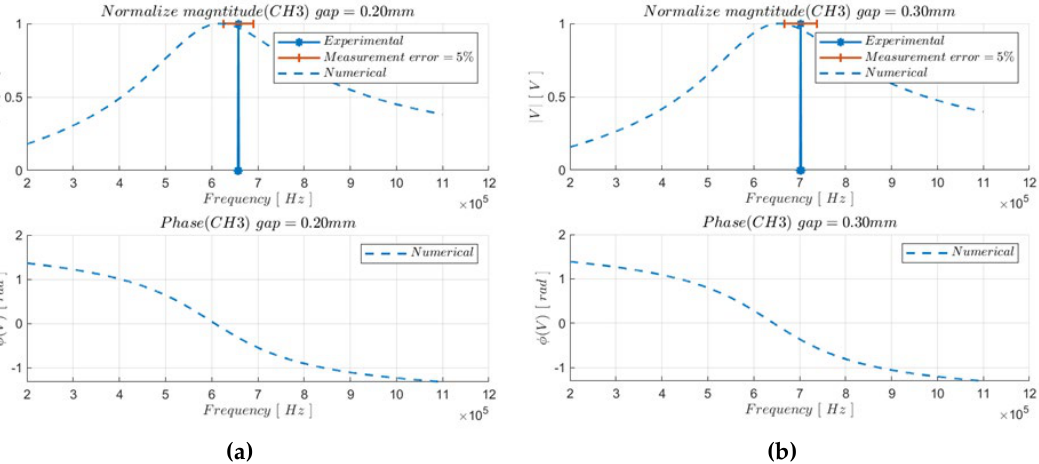
Figure 17. ( a ) Focus of the CH3 frequency response at 0.20 mm; ( b ) focus of the CH3 frequency response at 0.30 mm.